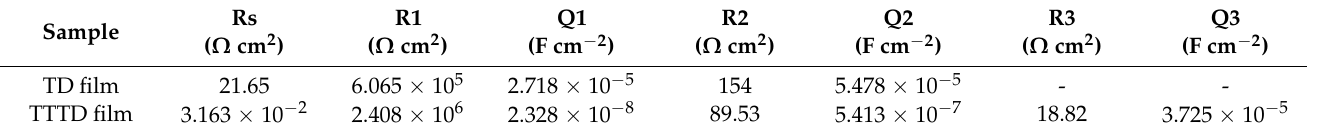
Figure 9. Fitted equivalent circuit diagram in weak alkaline solution: ( a ) TD film ( b ) TTTD film. Here, Rs is the solution resistance between the DLC film and the electrode, Q1 is the capacitance of the DLC film, R1 is the conduction resistance of the solution passing through the voids and defects of the DLC film, R2 is the conduction resistance of the passivation film voids and defects, Q2 is the capacitance of the passivation film, R3 is the polarization resistance between the film and the substrate, and Q3 is the electric double layer capacitance generated by the solution reaching the interface between the film and the substrate. Table 2. Electrochemical impedance fitting data of TD film and TTTD film in weak alkaline solution. Sample